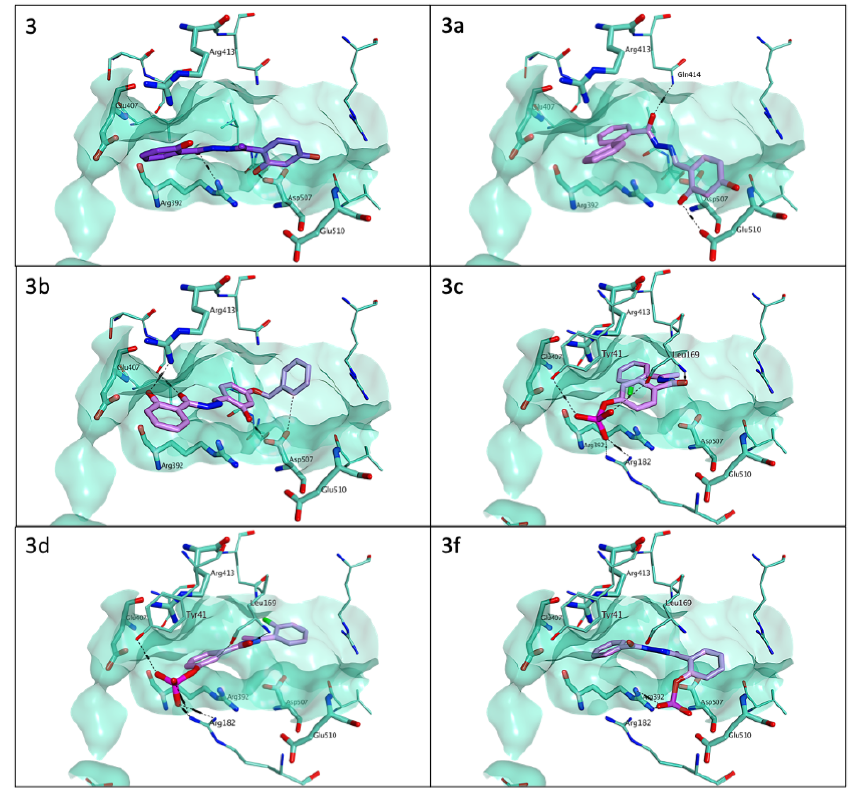
Figure 7. Proposed binding mode for 3 (carbon atoms in purple), 3a – d and 3f (carbon atoms in lilac) to the human norovirus RdRp (PDB ID 4LQ3). The binding site area is represented as green molecular surface. Human norovirus RdRp is represented as green ribbon, with carbon atoms in green. Black dashed lines represent non-bonded interactions (e.g., hydrogen bonds, electrostatic interactions) between the ligand and the amino acid residues of the protein.